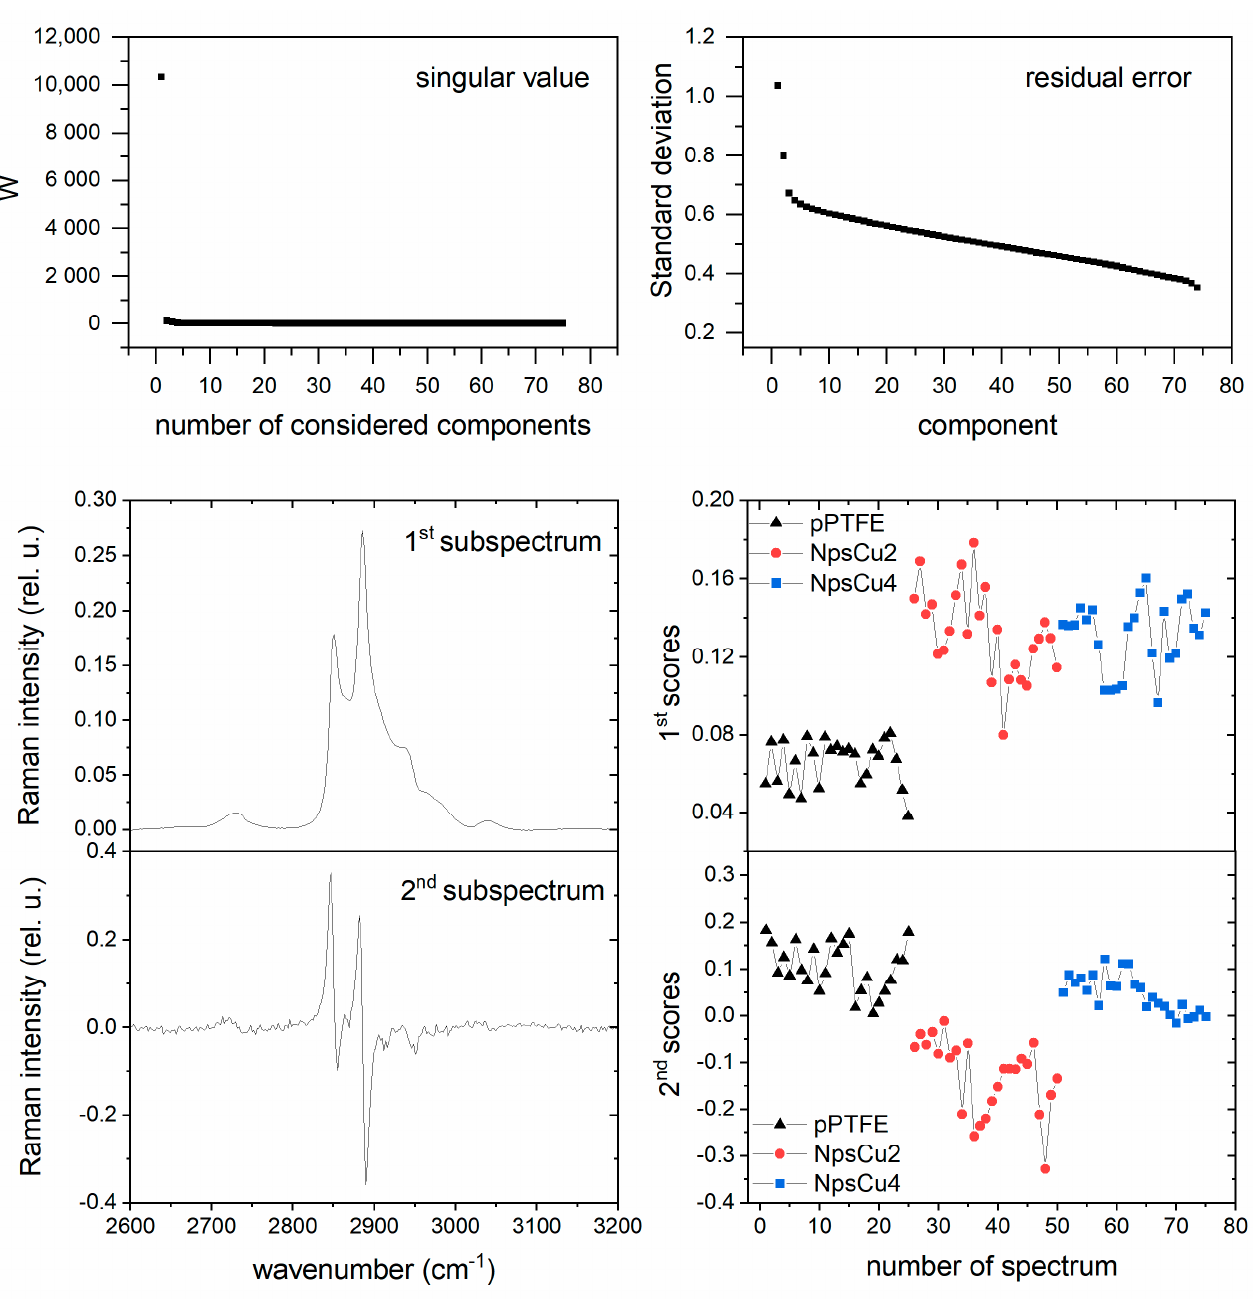
Figure 9. Results of FA for deposited liposome suspension at concentration of 0.5 mg/mL of DPPC, in the particular singular value assigned as W, standard deviation, first and second subspectrum and their belonging scores.